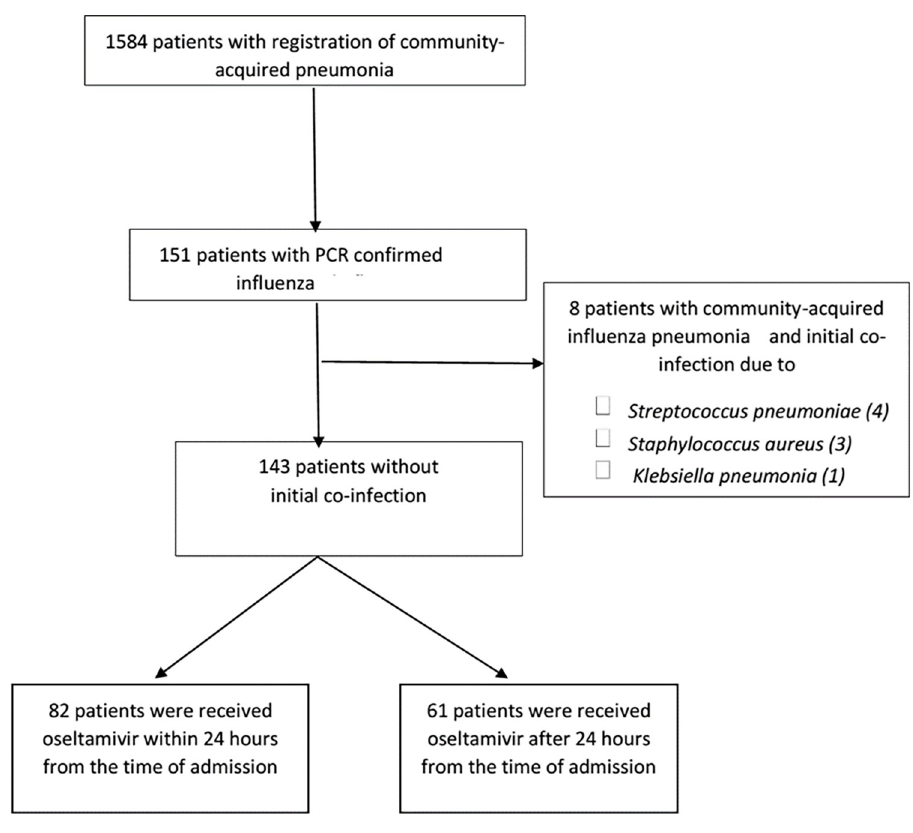
Fig 1. Flow chart of patient enrollment and inclusion in the